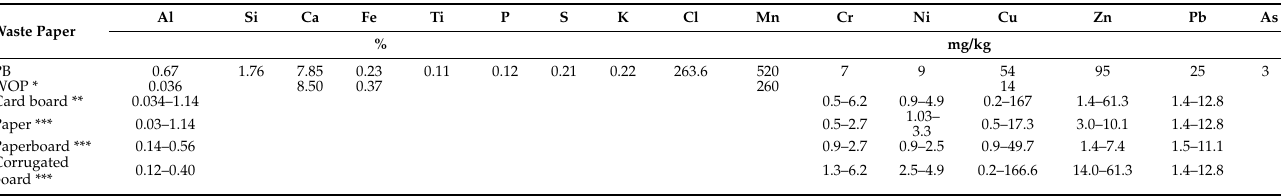
Table 4. Chemical composition of inorganic elements in waste paper and paper